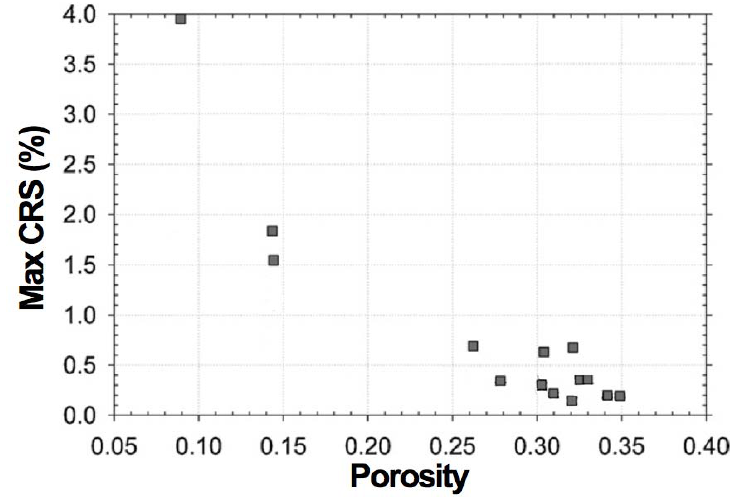
Figure 29. Maximum cumulative RedOx strain value (CRS) obtained after three isothermal cycles at 850 °C as a function of the total porosity of the Ni-YSZ composite [73]